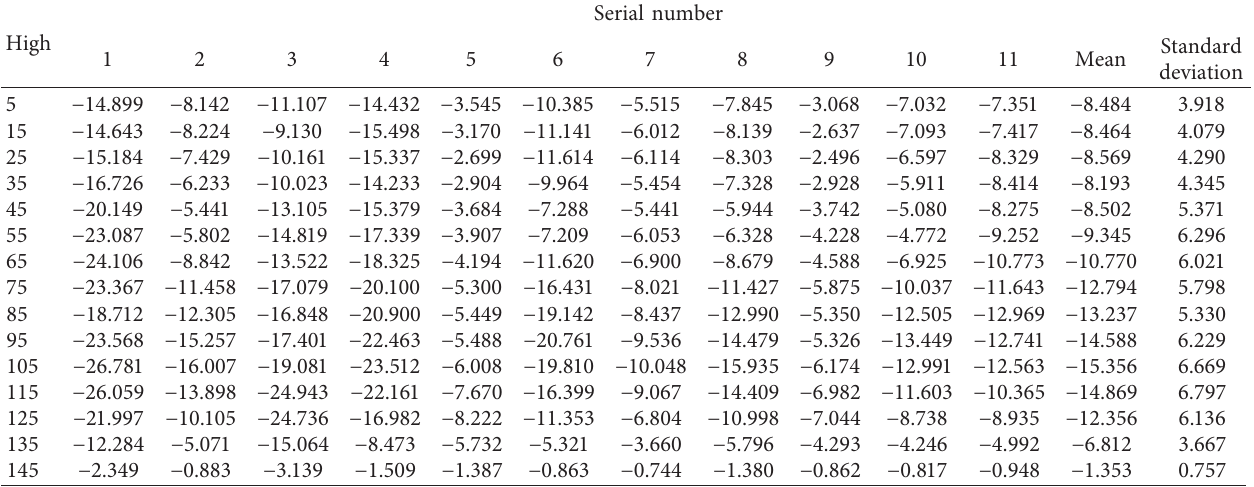
Table 8: Maximum earthquake tensile stresses of the 150m high chimney ignoring vertical eccentricities.